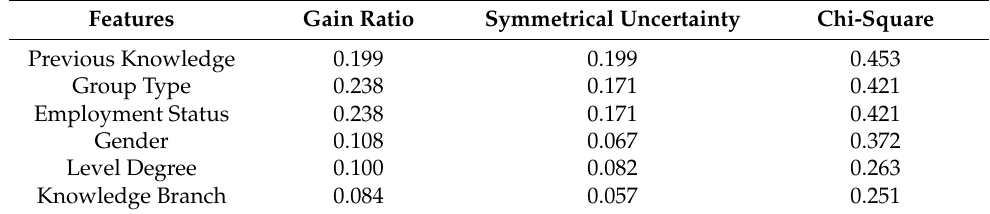
Table 3. Best performing features in the gain ratio, symmetrical uncertainty and chi-square feature selection algorithms.